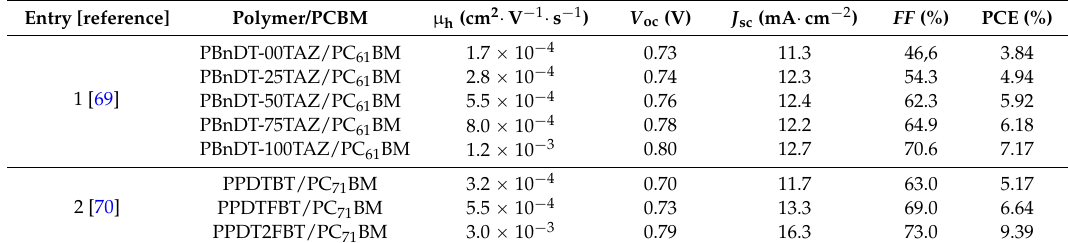
Table 4. Characteristic properties of polymer solar cells and charge carrier mobility measured on single carrier Space Charge Limited Current (SCLC) devices.